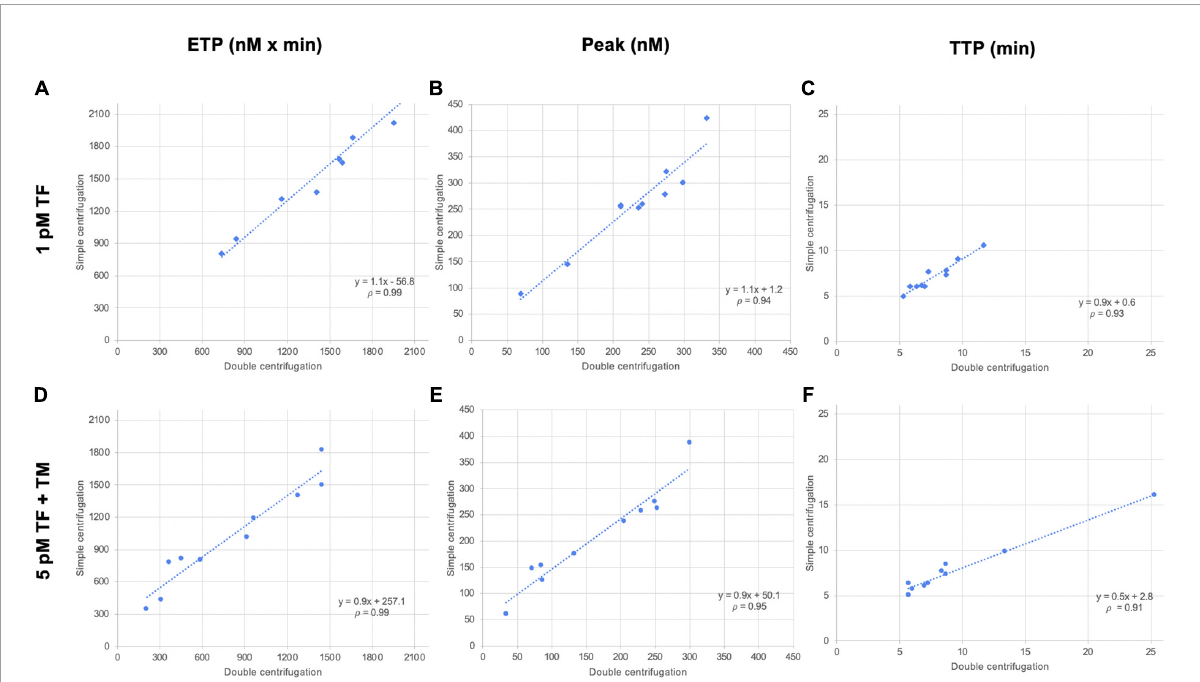
FIGURE3 Correlation of thrombin generation parameters of plasma samples prepared with two centrifugation schemes. Ten plasma samples (from patients) were prepared with single centrifugation or double centrifugation, and TG was initiated with 1 pM TF and 5 pM TF in the presence of TM. Scattergrams of endogenous thrombin potential [ETP, nM × min; (A, D) ], peak [nM; (B, E) ], and time to peak [TTP, min; (C, F) ]. TF, tissue factor; TM, thrombomodulin; p, Spearman’s rank correlation